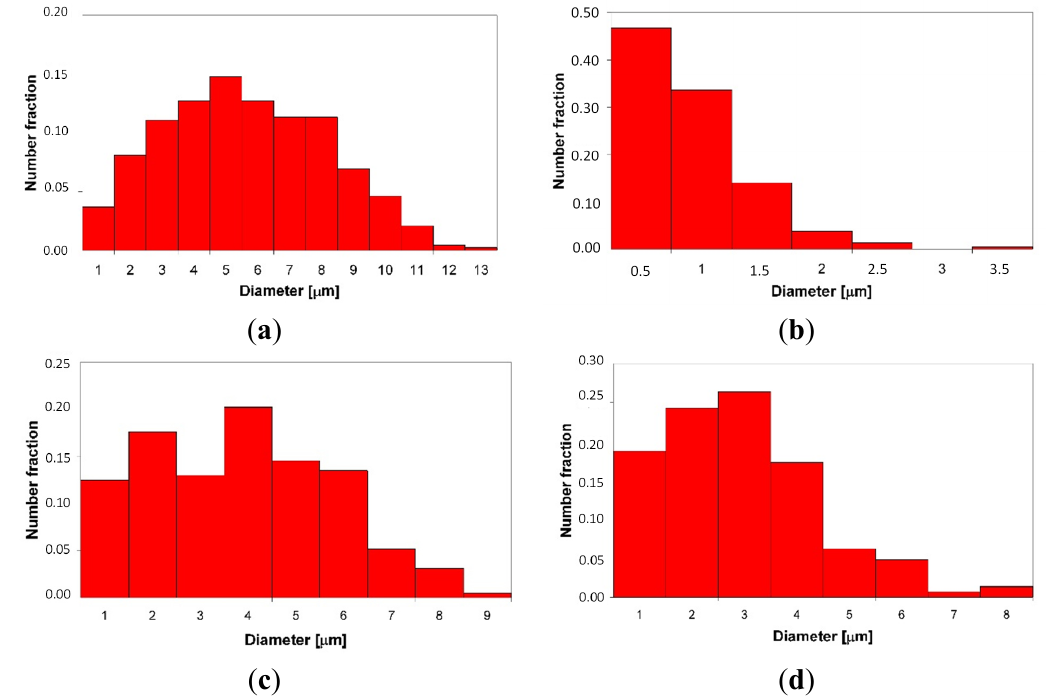
Figure 12. The grain size distribution of the L2 1 Fe 2 TiAl phase ( a , c ); and C14 Fe 2 Ti